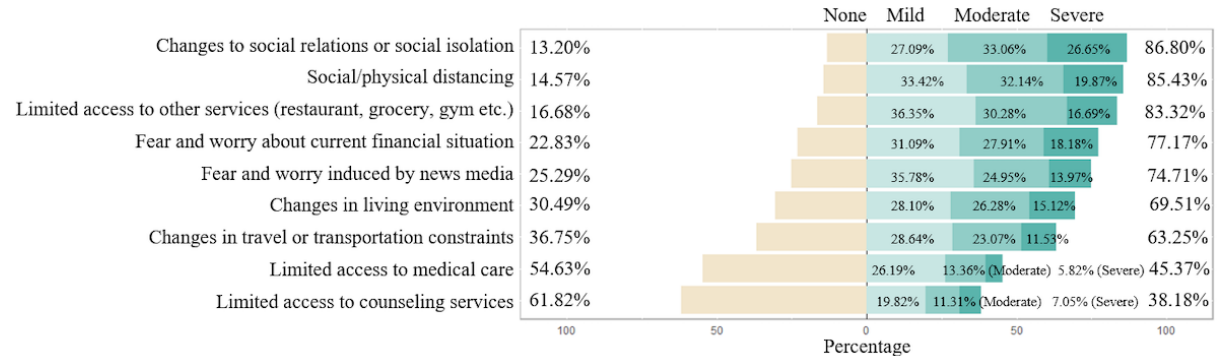
Figure 5. Lifestyle-related